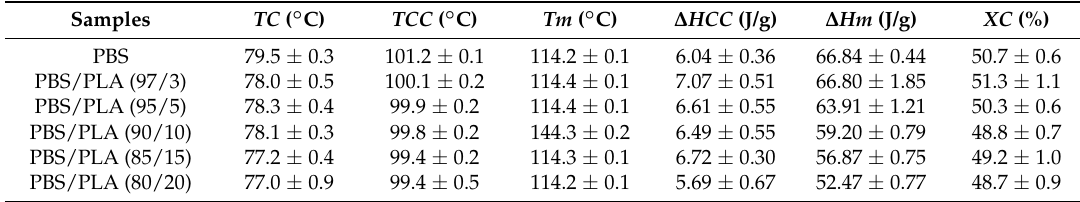
Table 1. DSC parameters of PBS phase in neat PBS, PLA and the as-extruded PBS/PLA composites.